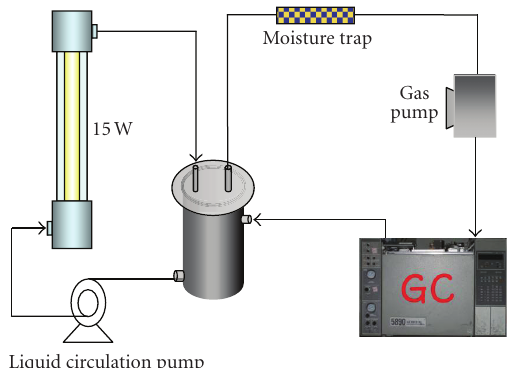
Figure 2: Schematic diagram of experimental apparatus for the measurement of photoactivity for water